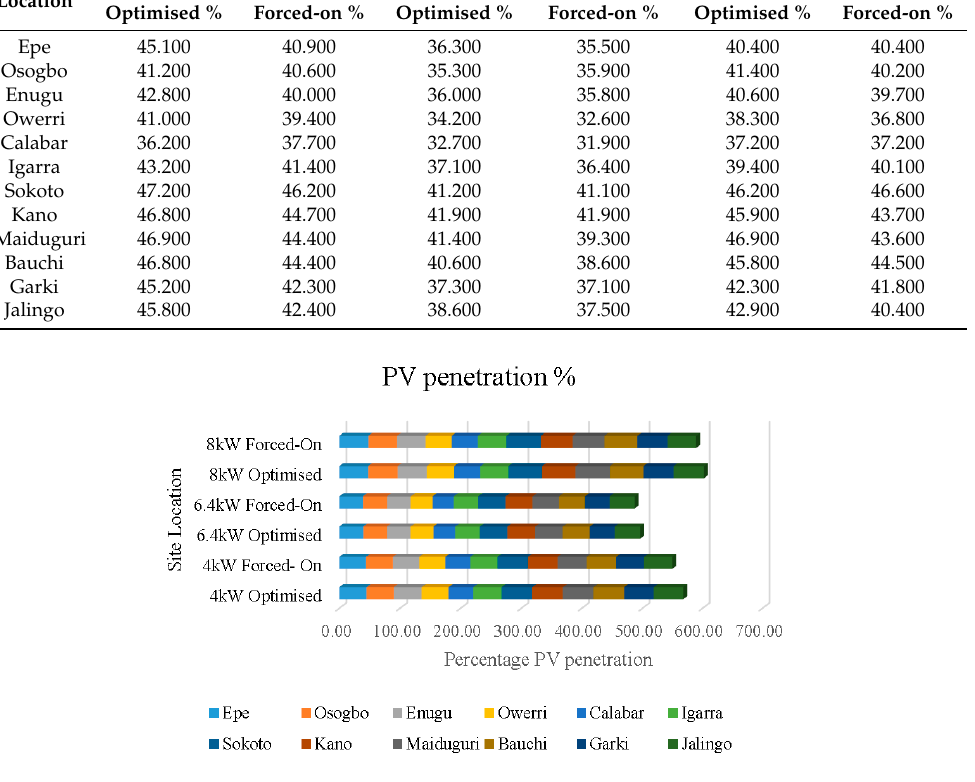
Figure 7. PV penetration (%). Table 7. Percentage penetration.